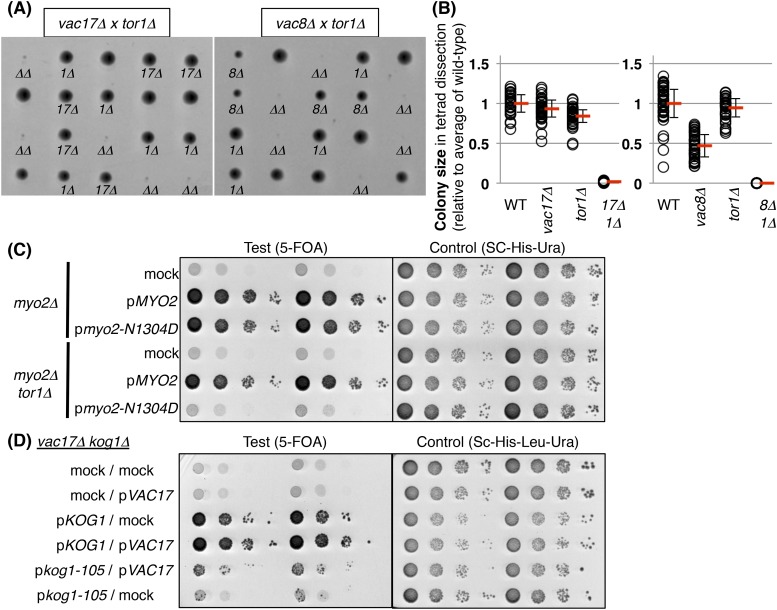
TORC1-SCH9 is required for the viability of vacuole inheritance mutants.(A) The tor1Δ mutant exhibits a synthetic growth defect with vac17Δ and vac8Δ. Results of tetrad dissection of heterozygous diploids, VAC17/vac17Δ TOR1/tor1Δ and VAC8/vac8Δ TOR1/tor1Δ. vac17Δ = 17Δ; vac8Δ = 8Δ; tor1Δ = 1Δ; vac17Δ tor1Δ or vac8Δ tor1Δ double mutants = ΔΔ are indicated. (B) Quantification of colony size, relative to average of wild-type colonies. A total of 34 tetrads and 39 tetrads were analyzed for vac17Δ tor1Δ and vac8Δ tor1Δ, respectively. (C) The tor1Δ mutant exhibits a synthetic growth defect with the myo2-N1304D mutant. Plasmids were transformed into a myo2Δ and myo2Δ tor1Δ strain containing YCp50 MYO2. Plasmids tested were pRS413 (mock), pRS413 MYO2, or pRS413 myo2-N1304D. Transformed colonies were cultured in liquid media and serial dilutions were spotted onto SC+5-FOA or SC-His-Ura plate, and incubated at 24°C for 4 days. (D) The vac17Δ kog1-105 mutant showed synthetic growth defects. pRS313 (mock) and pRS415 (mock), pRS313 (mock) and pRS415 VAC17, pRS313 KOG1 and pRS415 (mock), pRS313 KOG1 and pRS415 VAC17, pRS313 kog1-105 and pRS415 VAC17, or pRS313 kog1-105 and pRS415 (mock) expressed in vac17Δ kog1Δ with pRS316 KOG1. Transformed colonies were cultured in liquid media and serial dilutions were spotted on SC-His-Leu+5-FOA or SC-His-Leu-Ura plates, and incubated at 24°C for 5 days.